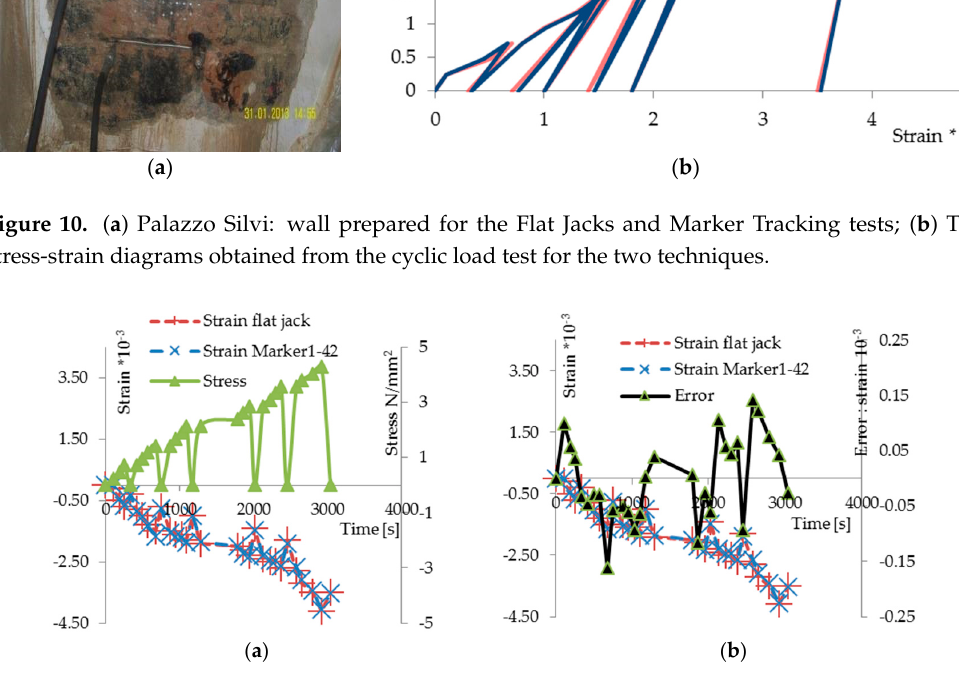
Figure 11. ( a ) Stress/strain versus time: stress (right axis), strain (left axis). ( b ) Measurements with MT (blu line) e deformometer (red line). Black line shows the values of the differences between two measurements (scale in right axis: strain 10 − 3 ).